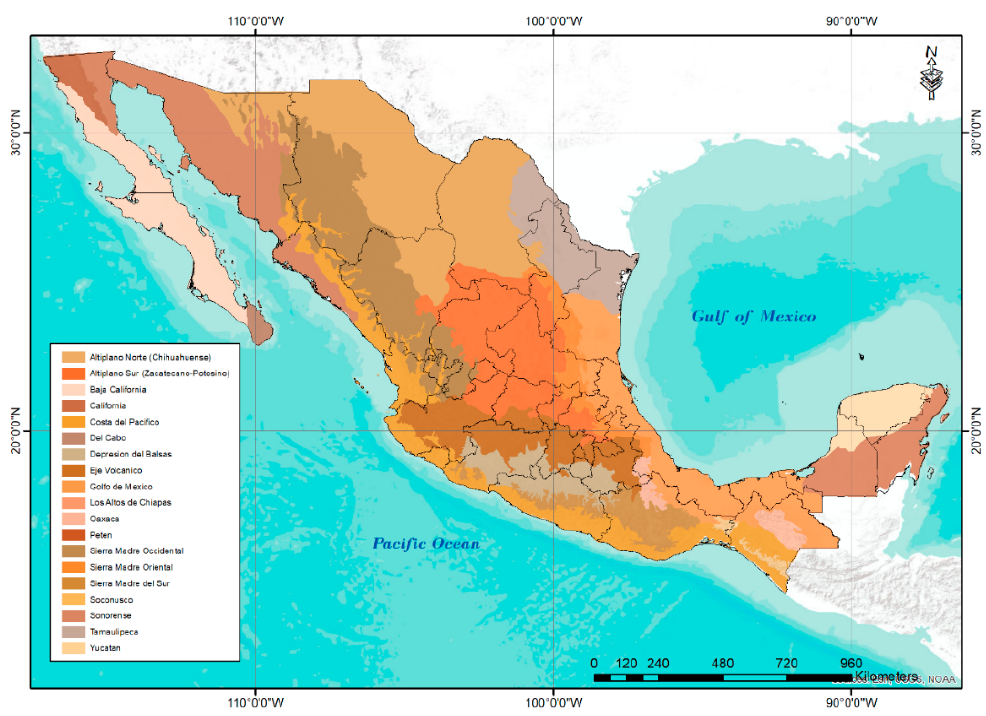
Figure 8. Physiographic Provinces of Mexico proposed in 2016 by “Comisión Nacional para el Conocimiento y Uso de la Biodiversidad” (CONABIO) [52].